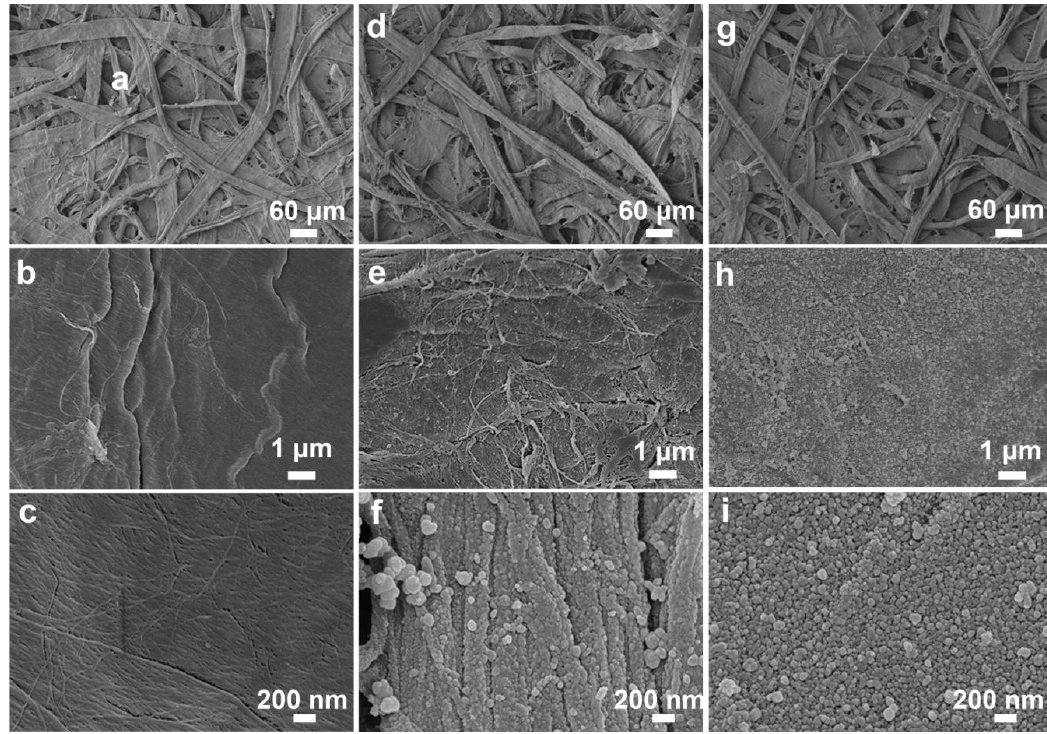
Figure 2. Scanning electron microscope(SEM) images of the FP strips ( a – c ), FP@PDA strips ( d – f )